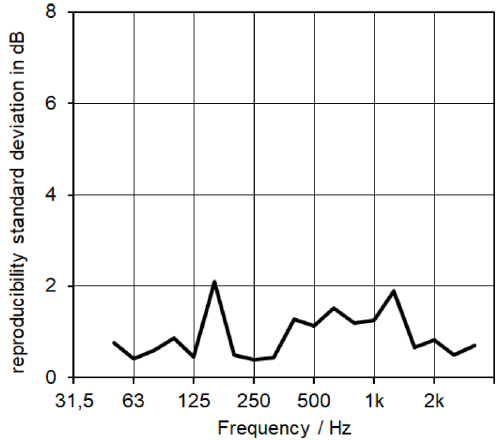
Figure 20. Reproducibility standard deviation of the single equivalent source mobility level.